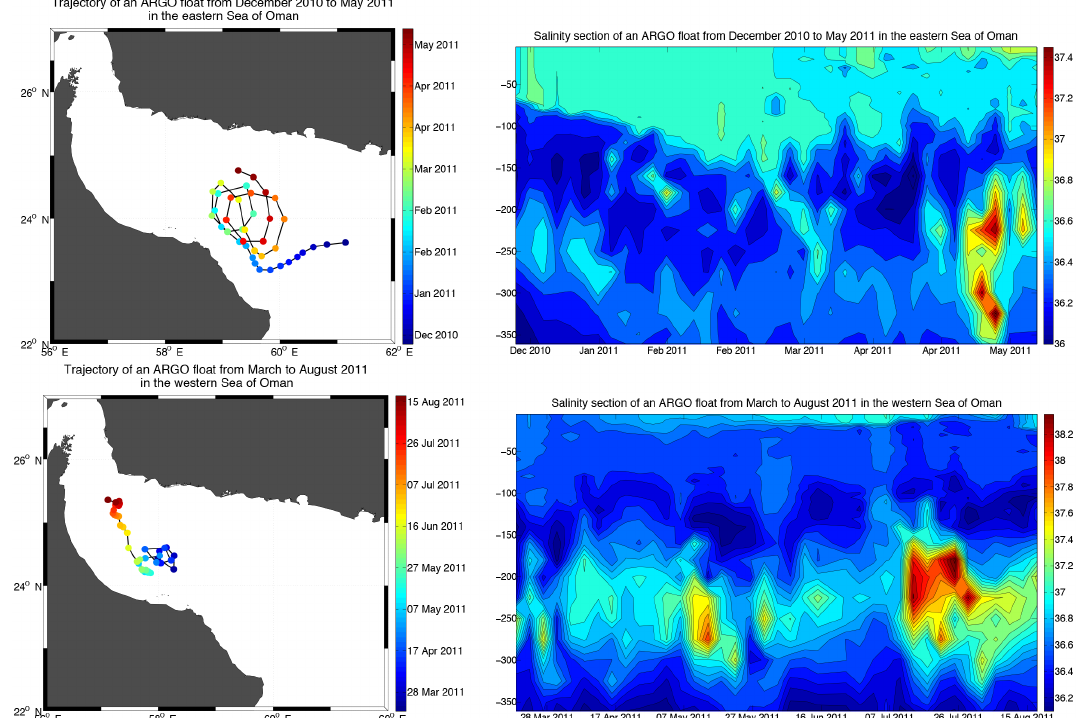
Figure 10. ARGO floats 2901370 (top) and 2901387 (bottom), trajectories (left) and salinity sections (right) in the eastern and western Sea of Oman. Float 2901370 (up) enters the Sea of Oman with anticyclonic loops, is stopped by the front in March 2011 and then looped cyclonically until late May 2011, between A1 and A3. Float 2901387 looped cyclonically from March to May 2011 before moving northwest. Patches of salty PGW are observed, with the strongest in July, when the float is found near the position of cascading